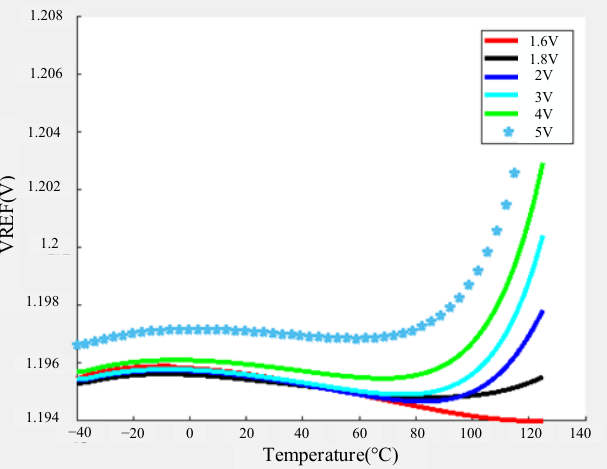
Figure 13. The proposed BGR circuit’s output voltage varies with the supply voltage.